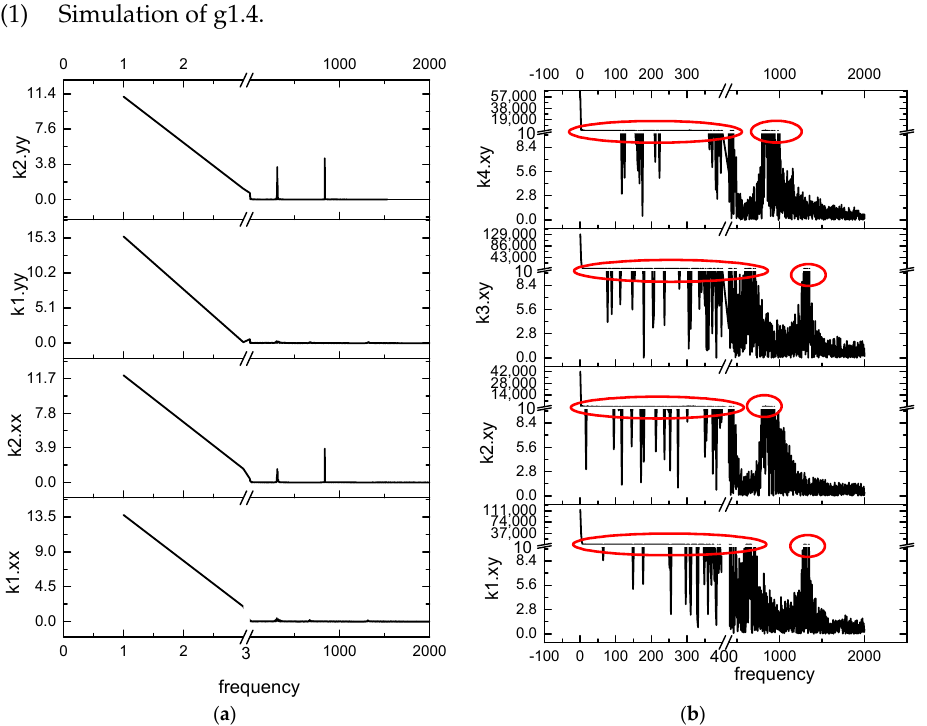
Figure A1. Identified bearing coefficients changing with frequency of g1.4 based on Algorithm I considering adjustment point and sensor resolution 1a: ( a ) obtained main stiffness coefficients in x and y directions from 0 to 2000 Hz; ( b ) obtained main damping coefficients in x and y directions.